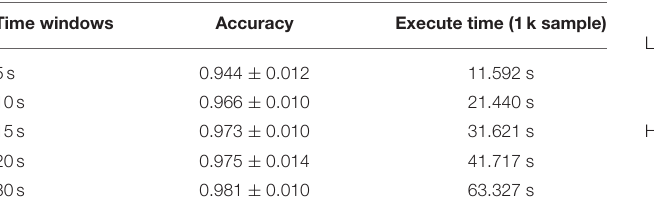
TABLE 3 | The effect of window size on the accuracy (mean and standard deviation) and the executing time.